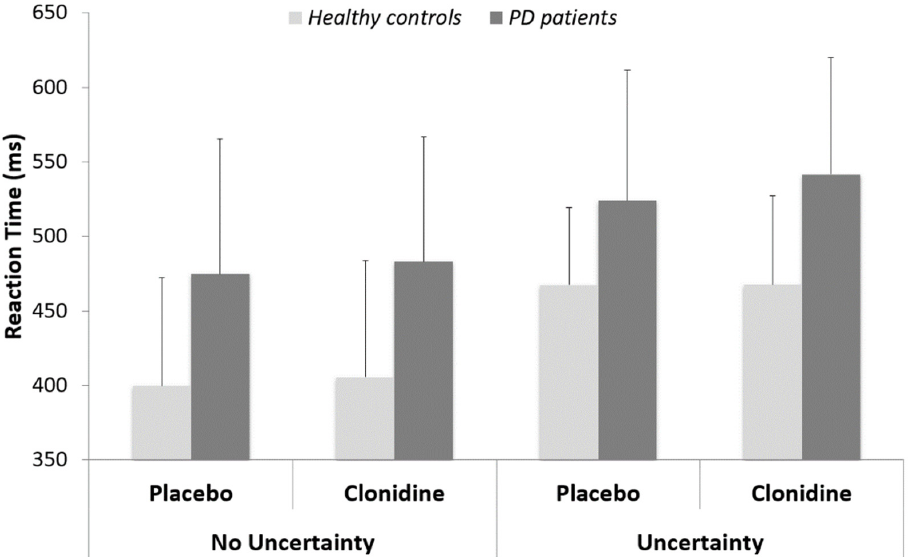
Figure 3. Reaction times (means and standard deviations) for PD patients versus healthy matched controls.